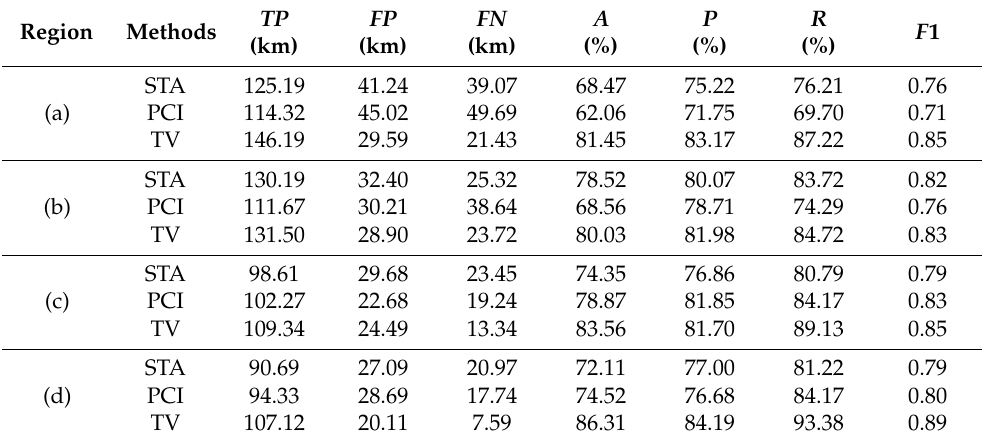
Table 2. Comparison of accuracy using different algorithms. TV, tensor voting; TP, true positive; FP, false positive; FN, false